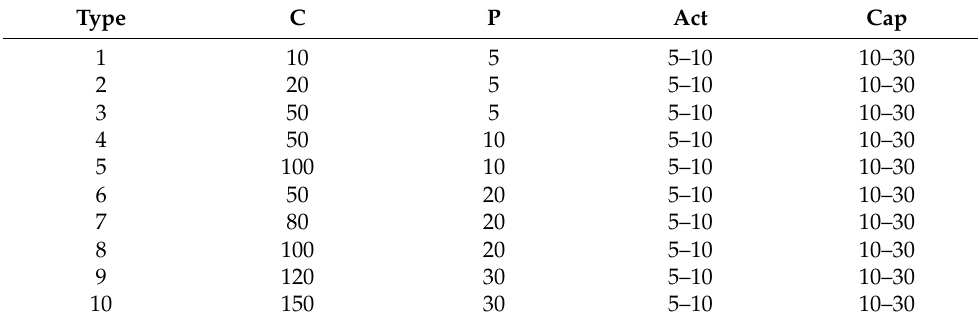
Table 1. Definition of the instances of the problem for the first set of computational